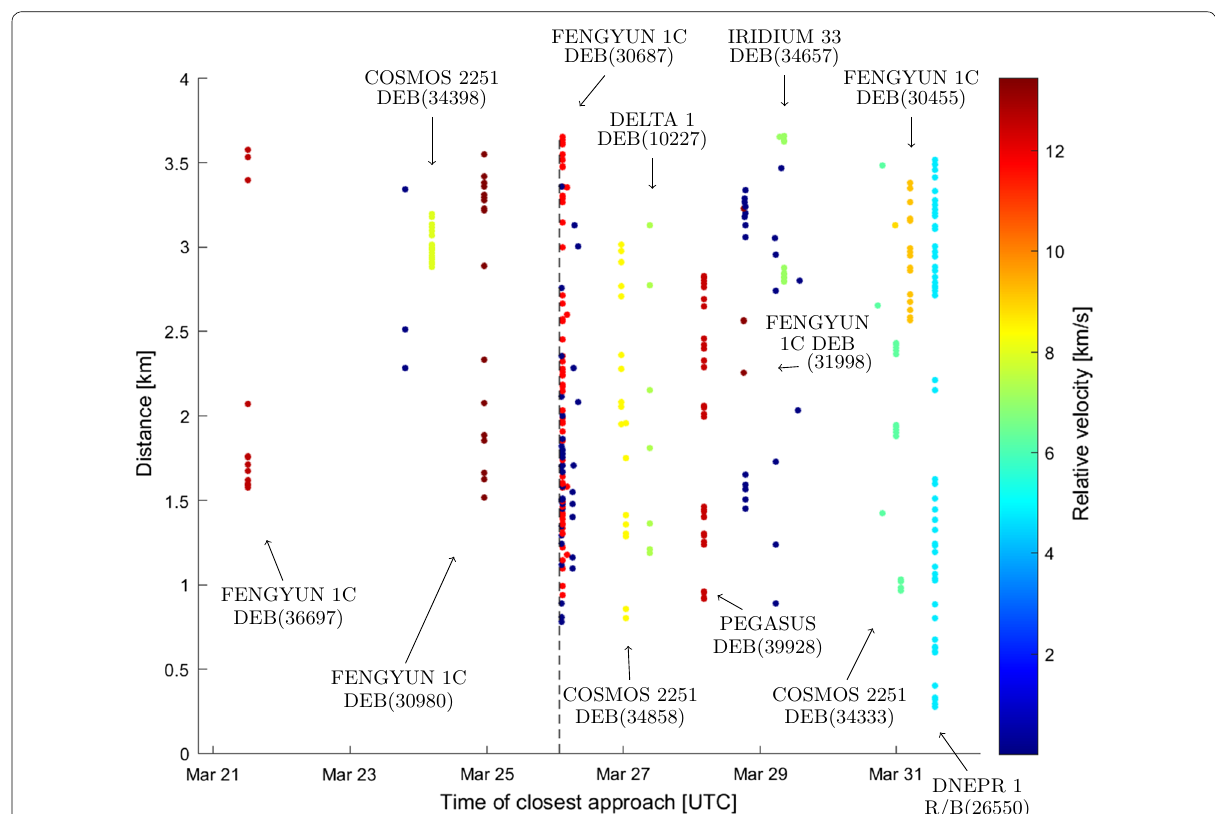
Fig. 5 Calculated close approach warnings for Hitomi. The close approaches resulting from debris objects are labelled with the NORAD ID in brack- ets . The dashed vertical line indicates the estimated breakup